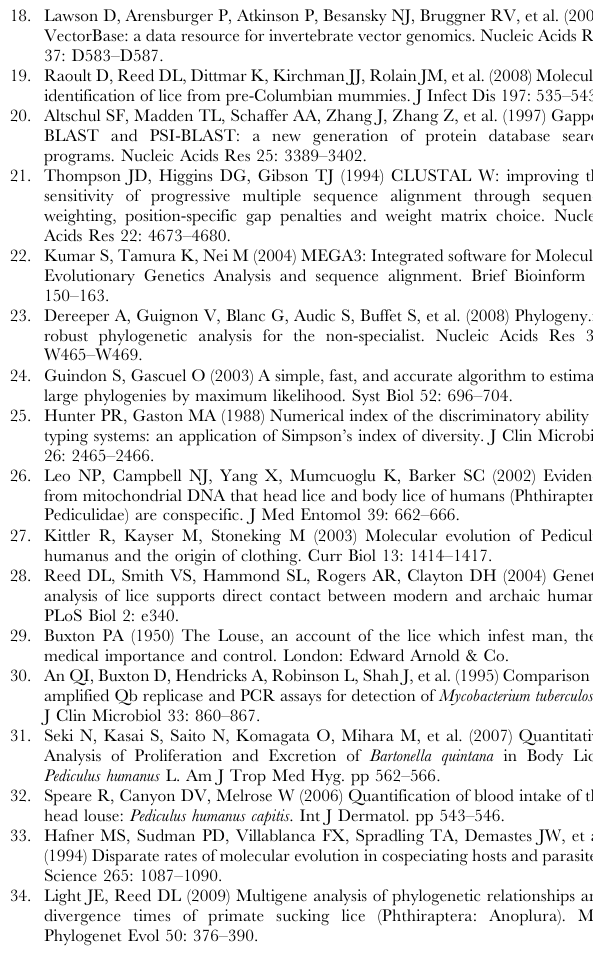
Figure S1 Phylogenetic organization of 207 human lice based on concatenation of two nuclear intergenic spacers, S2 and S5, using the Neighbor-joining method. Figure S2 Phylogenetic organization of 207 human lice based on concatenation of two nuclear intergenic spacers, S2 and S5, using the Maximum parsimony method. Figure S3 Phylogenetic organization of 174 human lice based on concatenation of two nuclear intergenic spacers, PM1 and PM2, using the Neighbor-joining method.